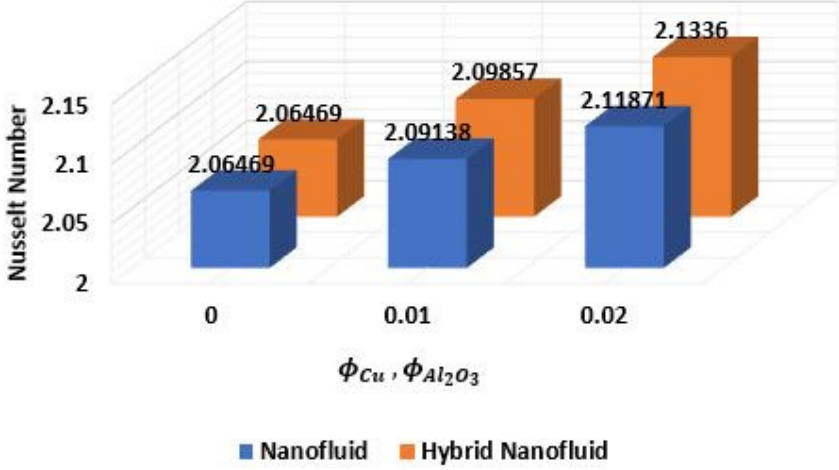
. φ φ 2 O 3 , . Cu Al O 2 3